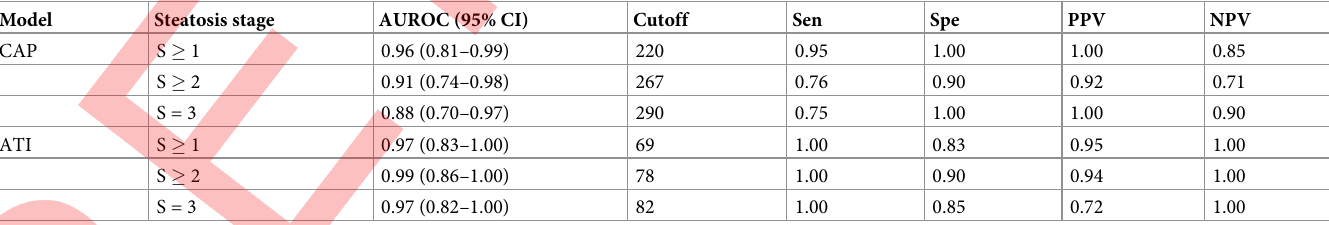
ATI: attenuation imaging; AUROC: area under the receiver operating characteristic curve; CAP: controlled attenuation parameter; CI: confidence interval; NPV, negative predictive value; PPV, positive predictive value; Sen, sensitivity; Spe, specificity. Cut-off values were obtained from the original